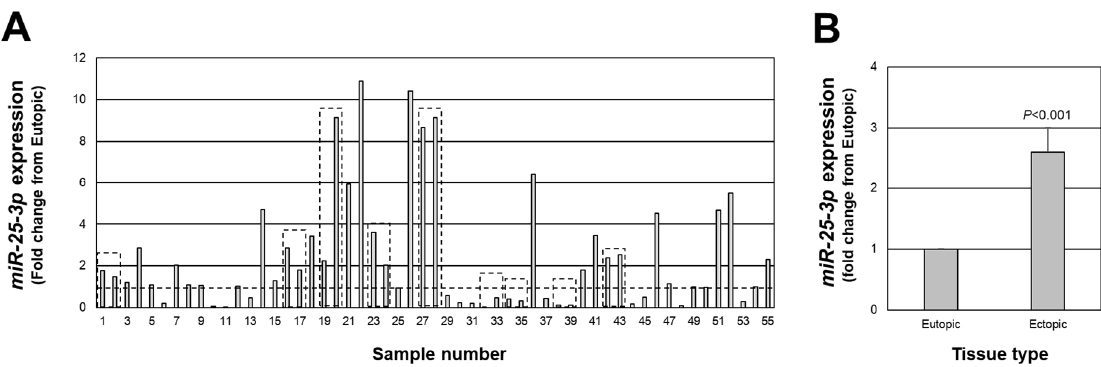
Figure 2. Fold change in miR ‐ 25 ‐ 3p expression in peritoneal endometriotic lesions. Data are expressed as the fold change from eutopic endometrial levels for each lesion ( A ) as well as the overall average fold change ( B ). Broken line in ( A ) depicts a fold change of 1.0 which is equal to the expression in eutopic endometrial tissue. Boxed areas indicate lesions obtained from the same patient at the time of surgery.